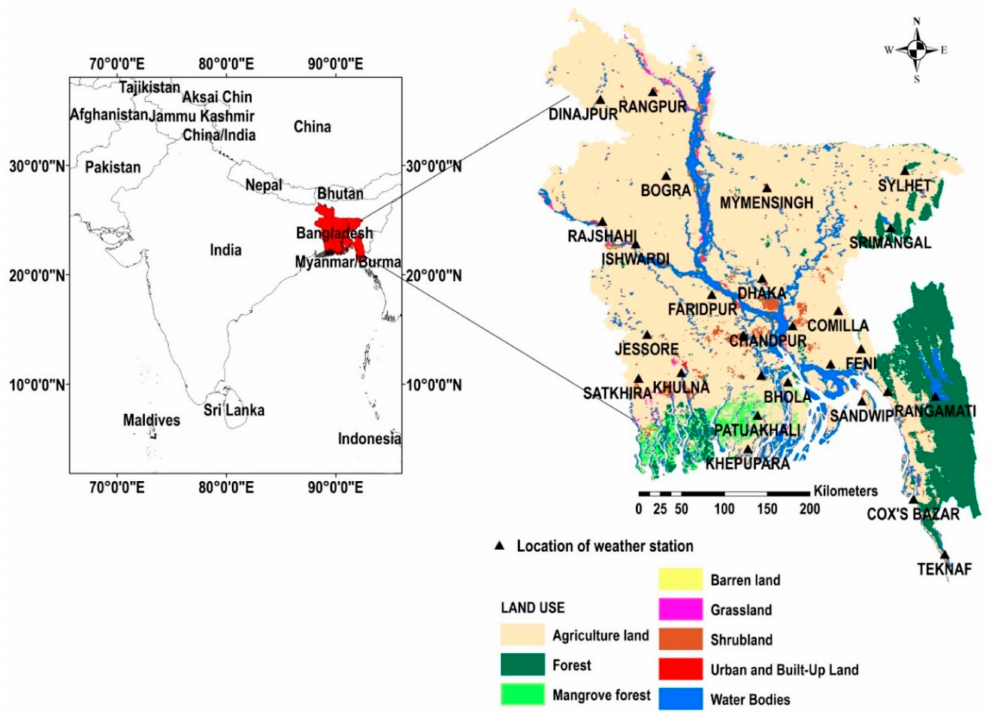
Figure 2. Location of meteorological stations and land use map of the study